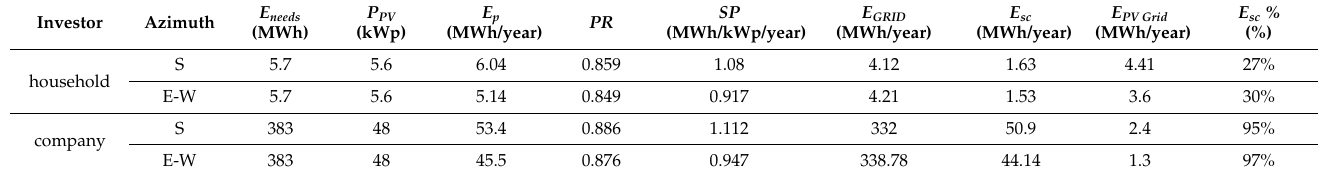
Table 3. Main PV system working parameters extracted from simulations performed in